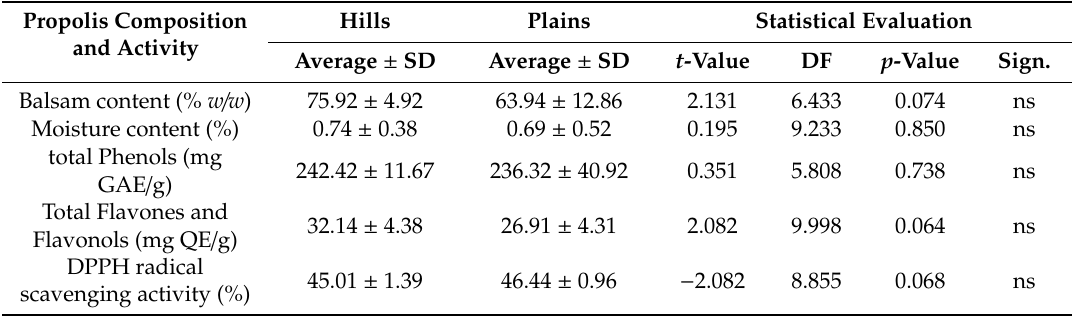
Table 1. Balsam and moisture content total antioxidant compounds and overall scavenging activity in raw propolis samples from hills (Ligurian–Piedmont Apennines) and plains (Po Valley).